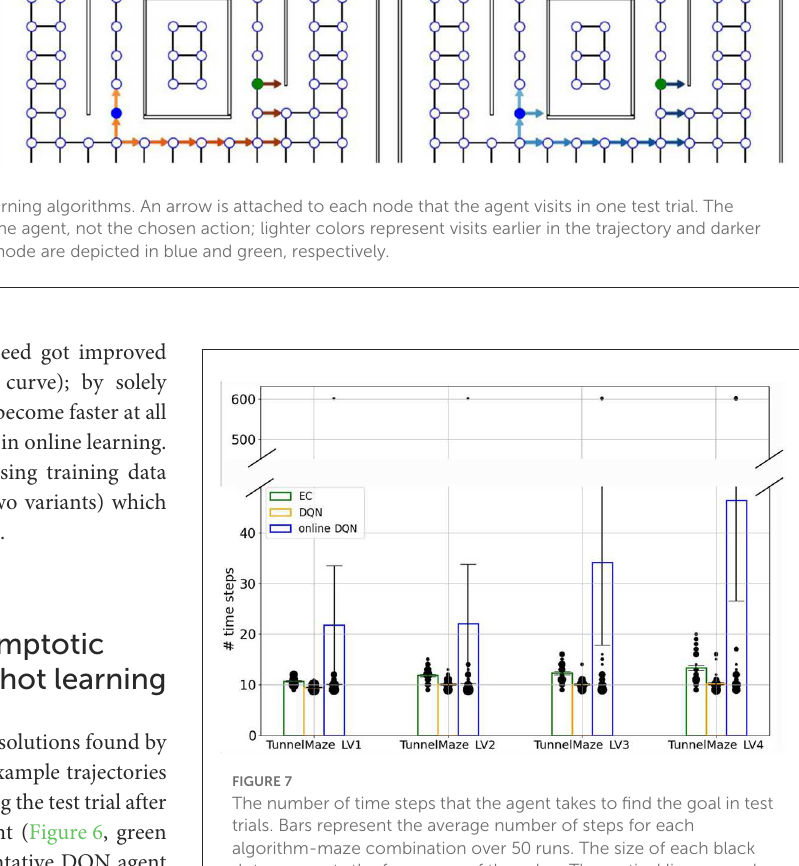
FIGURE7 The number of time steps that the agent takes to find the goal in test trials. Bars represent the average number of steps for each algorithm-maze combination over 50 runs. The size of each black dot represents the frequency of the value. The vertical line on each bar represents the standard error of the